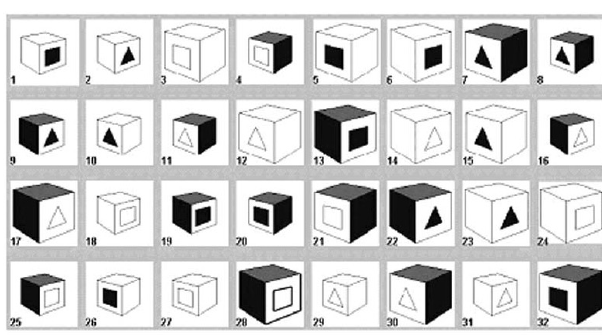
Figuur 1: Toetsvoorwerpe van Konsepverwerwingstoets Vir elke probleem word twee eienskappe vooraf gespesifiseer,